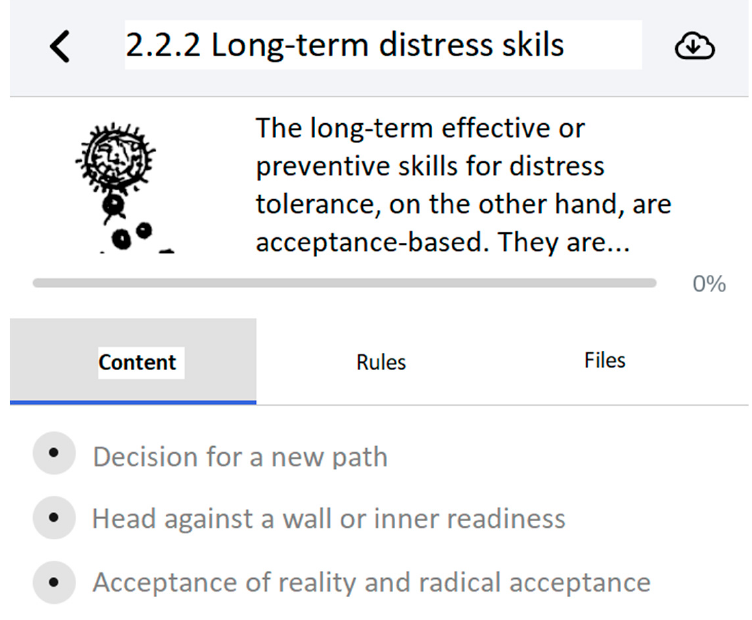
Figure A2. Tab “Content”.